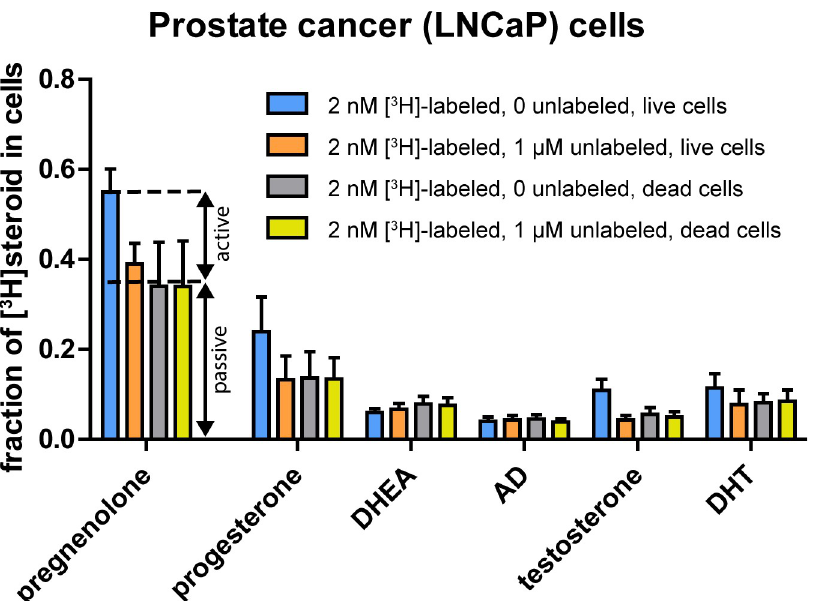
cells were incubated with 2 nM [ 3 H]-labeled steroids alone and with 1 μ M unlabeled steroids. For pregnenolone, progesterone, and testosterone, uptake of 2 nM [ 3 H]-labeled steroid with 0 unlabeled steroid in live cells was greater than uptake in any of the other three conditions (Tukey’s multiple comparison test after one-way ANOVA, pregnenolone: p = 0.004 for blue vs. orange; p < 0.001 for blue vs. gray and blue vs. yellow, progesterone: p = 0.01 for blue vs. orange; p = 0.02 for blue vs. gray; p = 0.02 for blue vs. yellow, testosterone: p < 0.001 for all three comparisons). For DHT, p = 0.07 from one-way